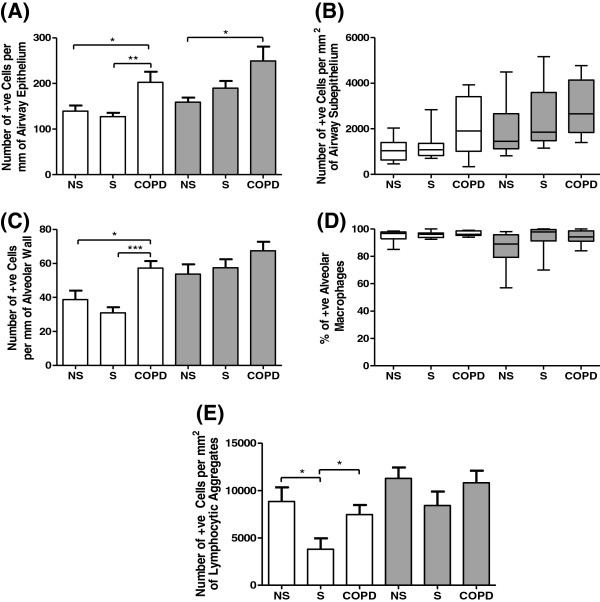
Quantification of LXR protein in lung tissue sections. The distribution of LXRα (white bars) and LXRβ (grey bars) was quantified in the epithelium (A) and subepithelium (B) of small airways, the alveolar wall (C), in alveolar macrophages (D), and within lymphocytic aggregates (E). Data shown are mean ± SEM (A, C, and E) or median ± range (B and D) of 10 non-smoking controls (NS) (apart from E n=8), 10 smoking controls (S) (apart from E n=6) and 10 COPD patients (apart from E n=9). *, ** and *** = significant difference in protein levels (p<0.05, p<0.01 and p<0.001 respectively).